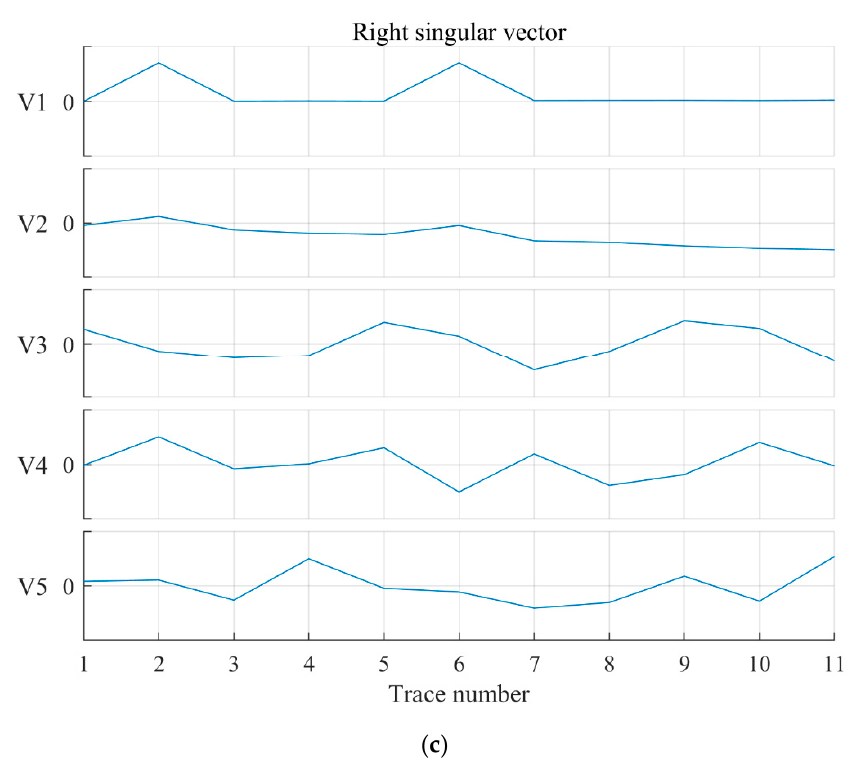
Figure 1. ( a ) Synthetic data; ( b ) the left singular vector diagram corresponding to the effective signal after SVD; ( c ) the right singular vector diagram corresponding to the effective signal.